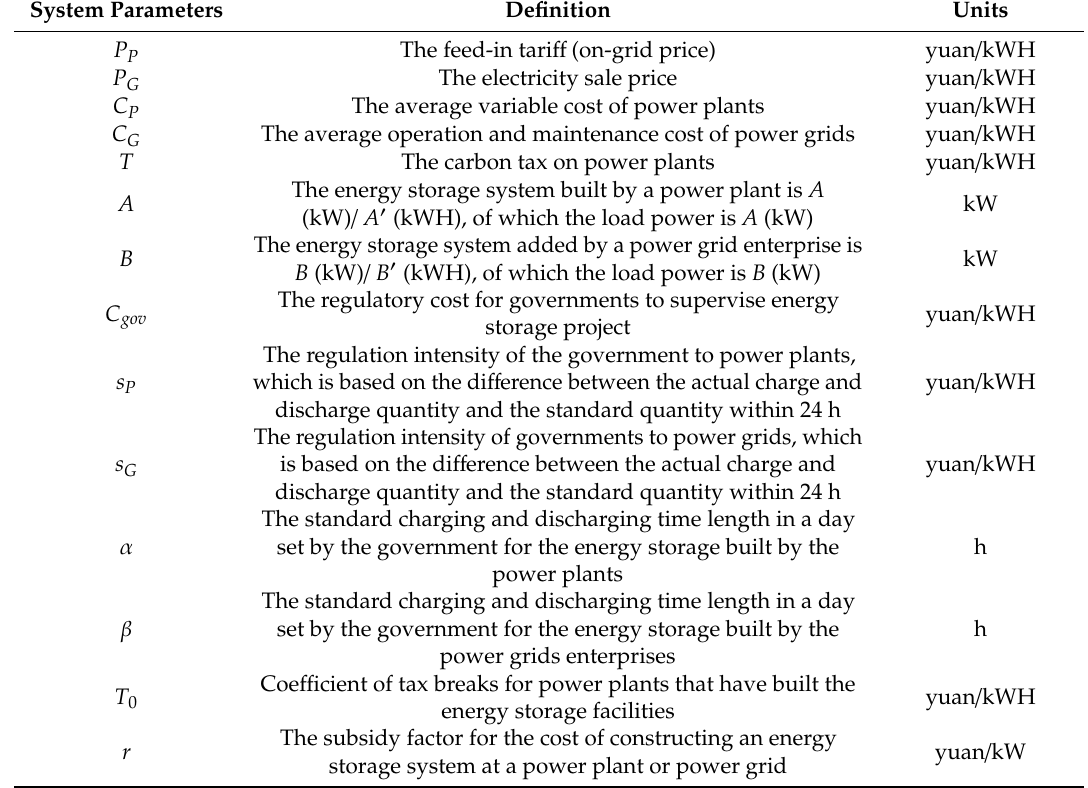
Table 2. System parameters of the trilateral strategy evolution